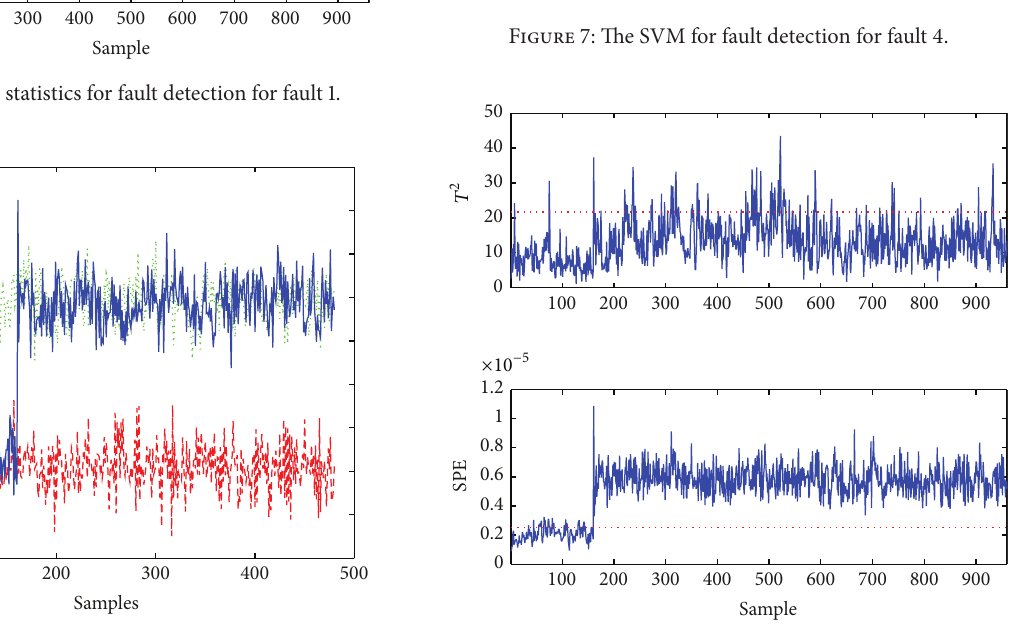
Figure 8: The PCA statistics for fault detection for fault